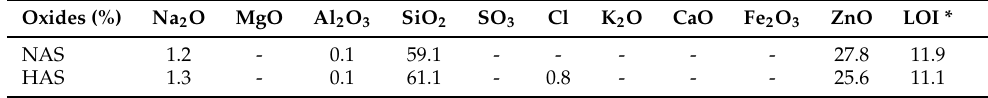
Table 1. Chemical analysis data (wt.%) of stevensite NAS and